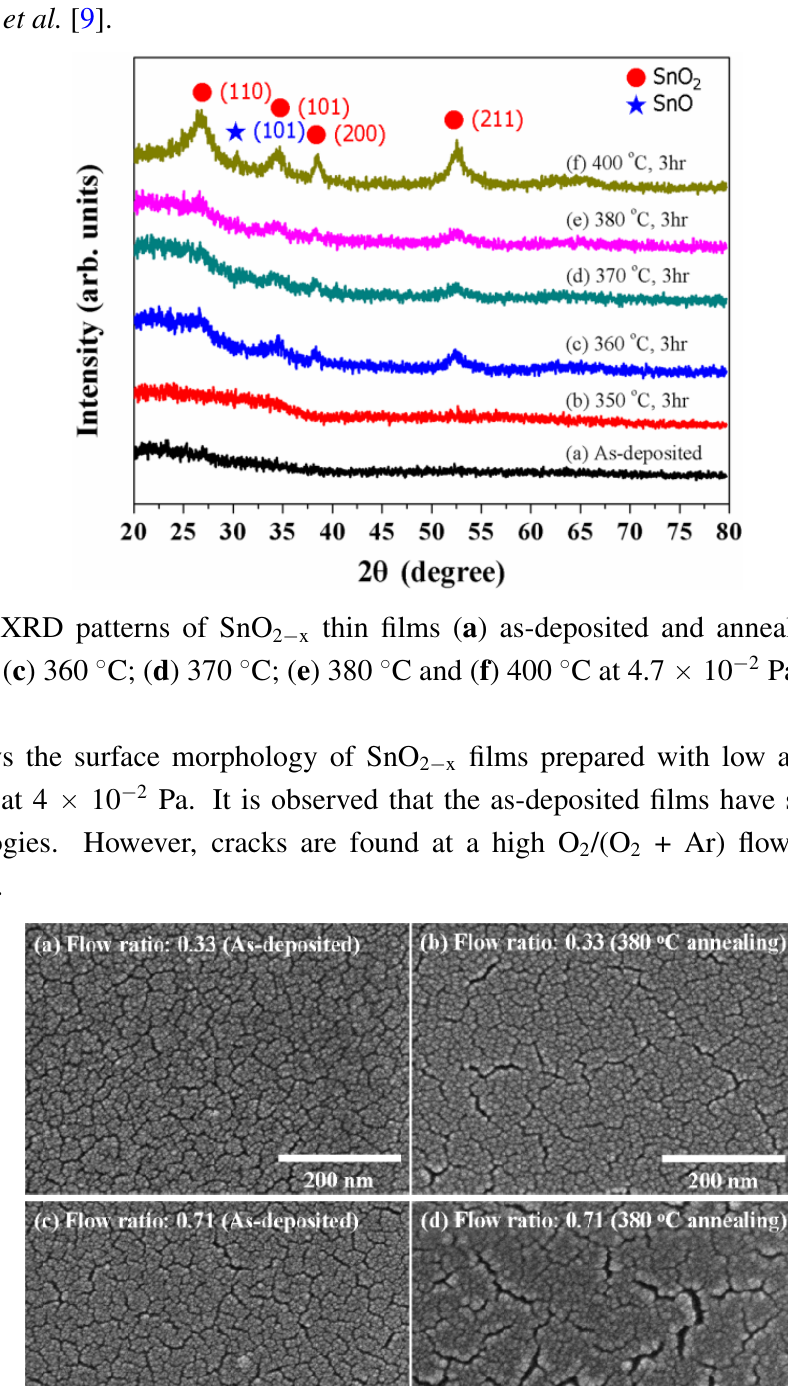
thin films prepared at various flow ratios 2 ´ x /(O + Ar) ( a ) for 2 2 /(O + Ar) ( c ) 2 2